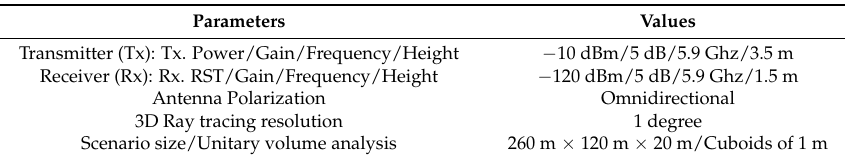
Table 2. Simulation